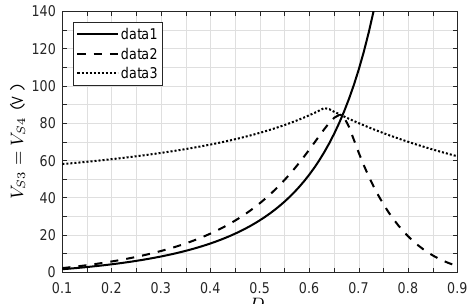
Figure 11. Voltage stress on semiconductors S 3 and S 4 (data 1: voltage converter appl; data 2: PV appl-, resistive load; data 3: PV appl, clamped